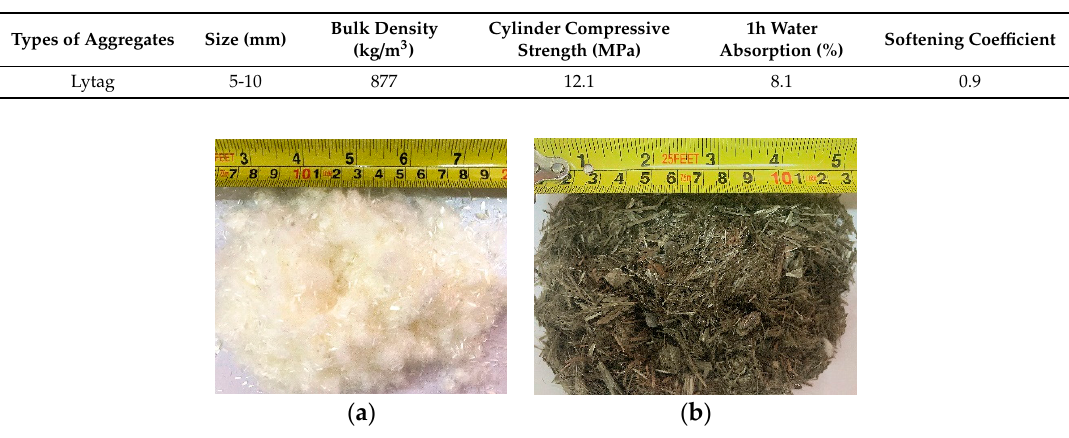
Table 2. The fundamental properties of coarse lightweight aggregate.